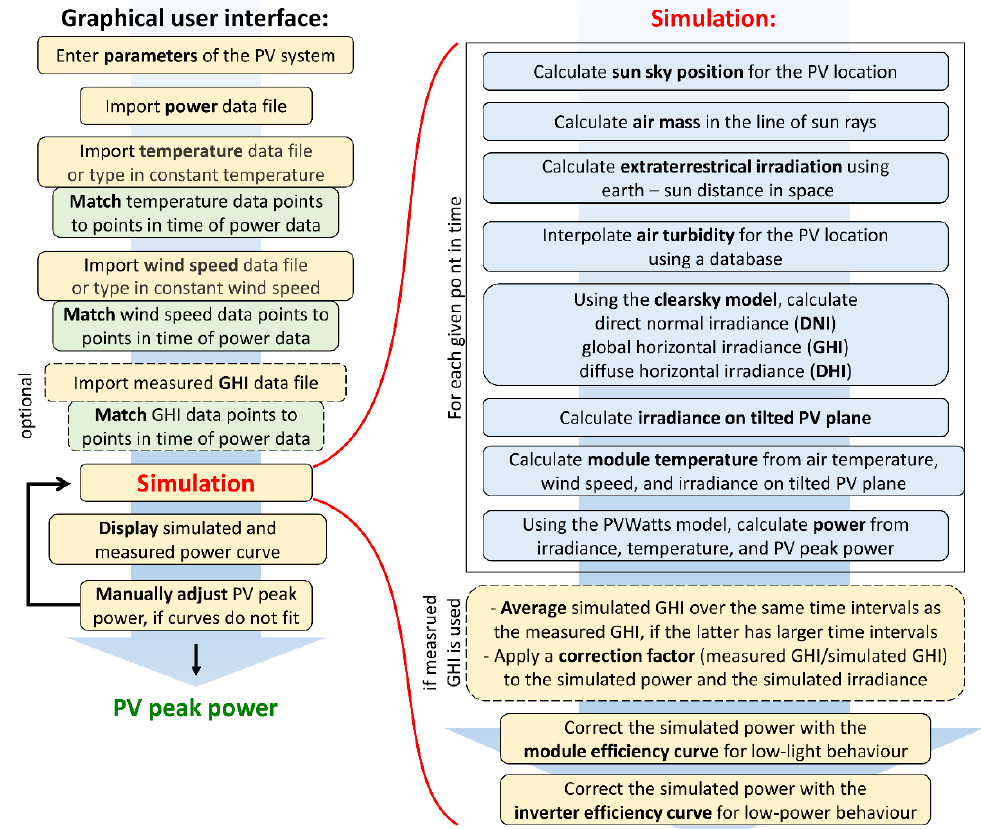
Figure 1. Flow diagram of PVcheck version 0.1. Pascal program parts are shown in orange and green boxes. “Matching” of temperature data points means that temperatures are only taken for the same points in time where imported power data is available. This is normally done by interpolation from the imported temperature data file. Matching of wind speed and GHI is done analogously. Python program parts using pvlib are shown in blue boxes and are enframed. Module and inverter efficiency curves are parts of the parameters of the system that have to be loaded in the beginning.